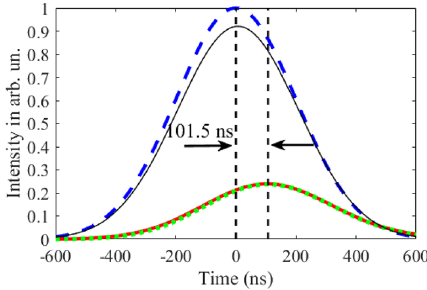
Figure 5. Time dependence of the intensity of the 14.4-keV Gaussian single-photon wave packet Eq. (36) at the entrance (blue dashed line) and exit from the absorber vibrating at the frequency � 0.38 (cid:31) , Eq. (14), corresponding to p 1 R 1 = The black solid thin line corresponds to T a 30 . The black and red solid lines are calculated by the numerical integration of Eq. (33), whereas the green T a = dotted line is calculated using Eq. (38) without taking into account the contributions of both the group velocity dispersion and the frequency-dependence of the absorption within each spectral